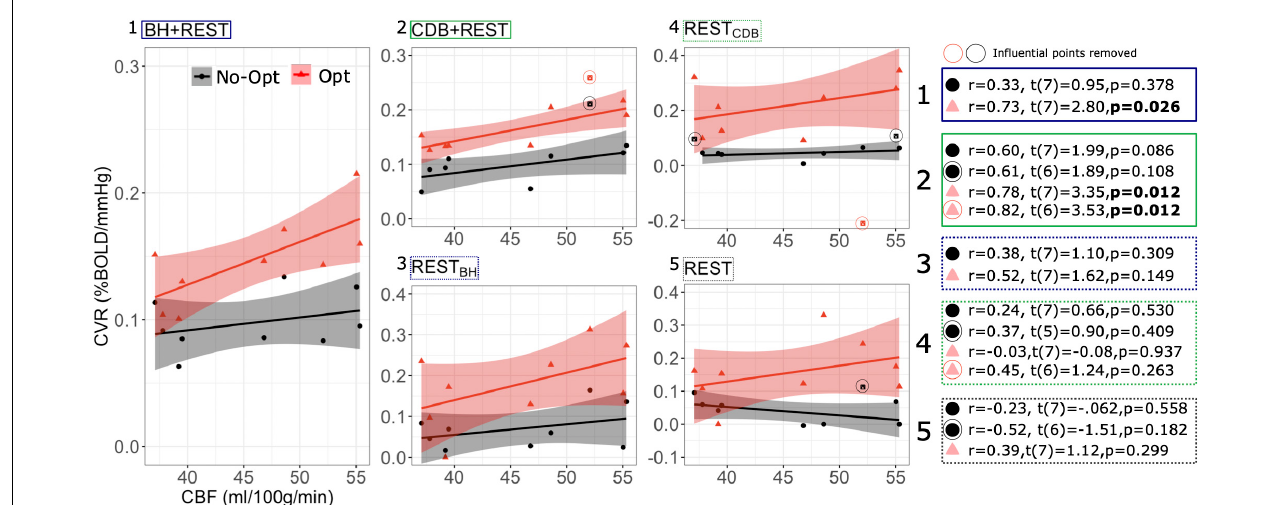
FIGURE 3 | Between-subject Pearson correlations between GM CBF values and GM BOLD-CVR values, shown for each data segment (1–5) and for CVR values with no lag optimization (No-Opt, black circles) and CVR values with lag optimization (Opt, pink triangles). The CBF and CVR values are medians over a GM mask and each dot represents one participant. On the right, statistical tests are shown with and without influential points removed. Influential points were classed as points with a Cook’s distance over 4/n, with n being the number of subjects. P -values are not corrected for multiple comparisons. The gray shaded regions around the fit lines indicate the 95% confidence interval of the correlation coefficient (fit line and confidence interval estimation did not include influential points, but influential points are still plotted